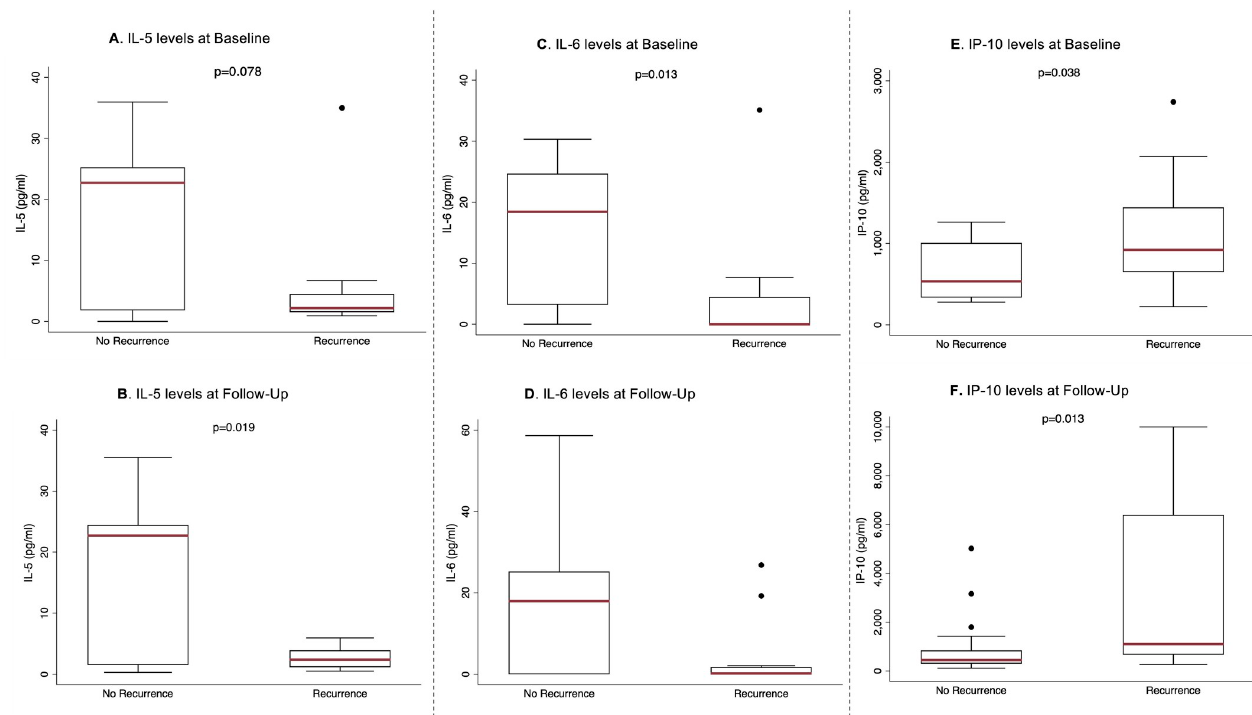
Fig 1. Baseline and follow-up cytokines and chemokines in individuals with no recurrence (sustained remission) compared to those with KS recurrence. A) No difference in baseline IL-5; B) IL-5 significantly higher at the time of follow-up in individuals with sustained remission compared to those with KS recurrence; C) IL-6 significantly higher at baseline in individuals with sustained remission compared to those with KS remission; D) IL-6 significantly higher at the time of follow-up in individuals with sustained remission compared to those with KS recurrence; E) IP-10 significantly lower at baseline in individuals with sustained remission compared to those with KS remission; F) IP-10 significantly lower at the time of follow-up in individuals with sustained remission compared to those with KS recurrence.